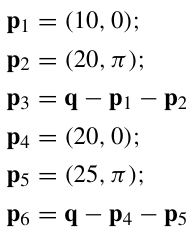
Fig. 4 Multiplicity plot for q = 4 GeV in the closed spin chain